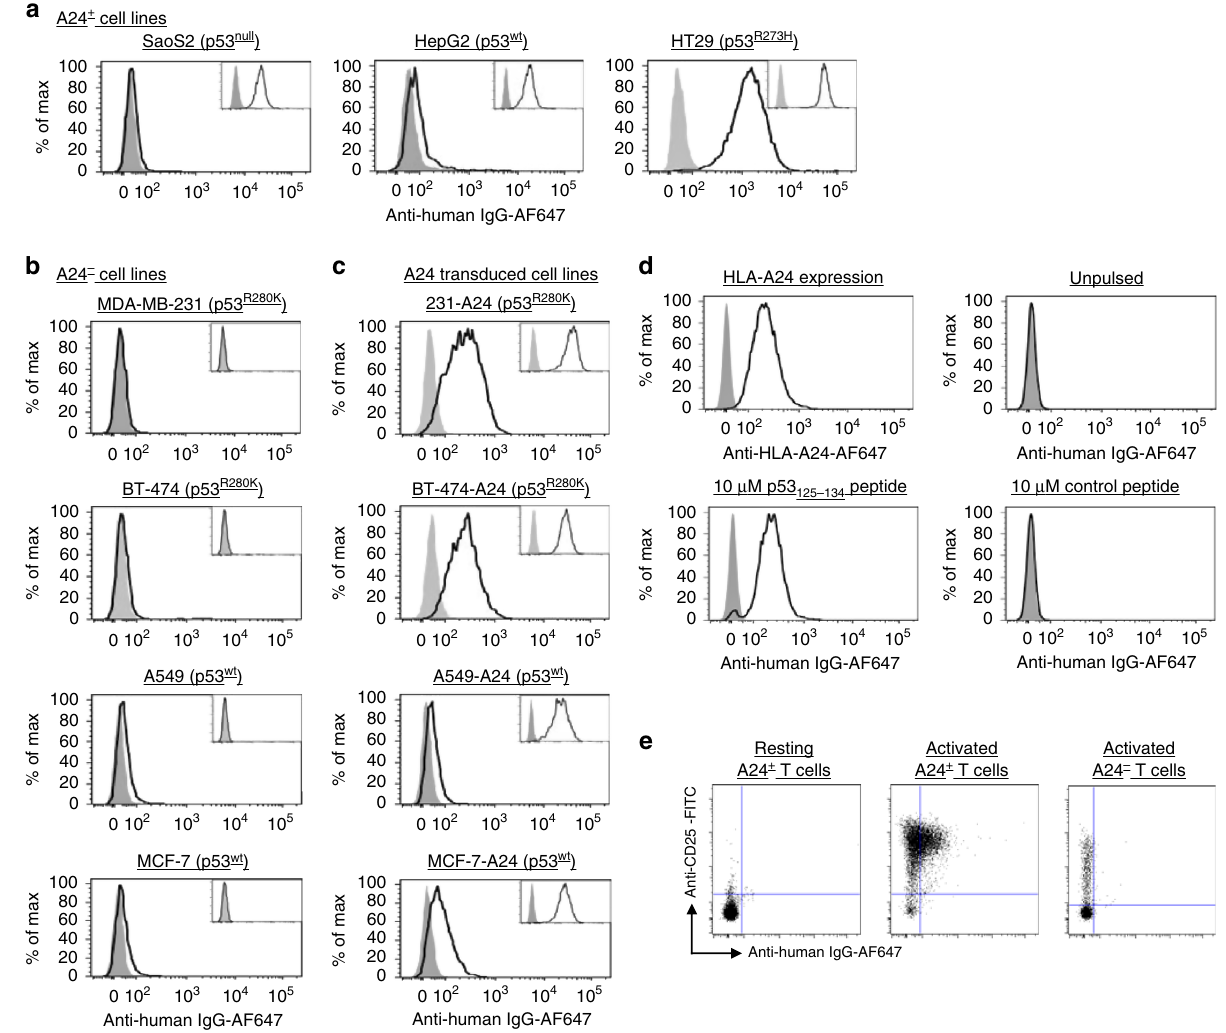
Fig. 4 Binding of endogenously processed p53 125 – 134 /A24 pMHCs on cells expressing wild-type and mutant p53. a Colon carcinoma cell line HT29 expressing HLA-A24 and mutant p53 R273H , osteosarcoma cell line SaoS2 expressing HLA-A24 with a null mutation of the p53 gene, while hepatocellular carcinoma cell line HepG2-expressing HLA-A24 and wild-type p53 were stained with 10 µ g mL − 1 P1C1TM. Signi fi cant staining was observed only with HT29 cells and minimal staining or no staining was seen with HepG2 and SaoS2 cells, respectively. HLA-A24-negative breast cancer cell lines MDA-MB- 231, BT474 and MCF7, and lung carcinoma cell line A549 were transduced with HLA-A24. Staining of the untransduced ( b ) and transduced ( c ) cells with P1C1TM showed signi fi cantly higher levels of p53 125 – 134 /A24 pMHCs on the surface of cells expressing both HLA-A24 and mutant p53 (MDA-MB-231 and BT474) compared to cells expressing wild-type p53 (A549 and MCF7). Insets show P1C1TM staining of the respective cell lines pulsed with 10 μ M of p53 125 – 134 peptides, indicating successful transduction. Data are representative of three independent experiments. d P1C1TM was used to stain HLA-A24 + PBMCs. No signi fi cant binding was observed in unpulsed PBMCs. P1C1TM staining was observed when pulsed with 10 µ M p53 125 – 134 peptides but not control peptides. e Staining of P1C1TM was observed only in activated HLA-A24 + T cells, but not resting HLA-A24 + T cells or activated HLA-A24 − T